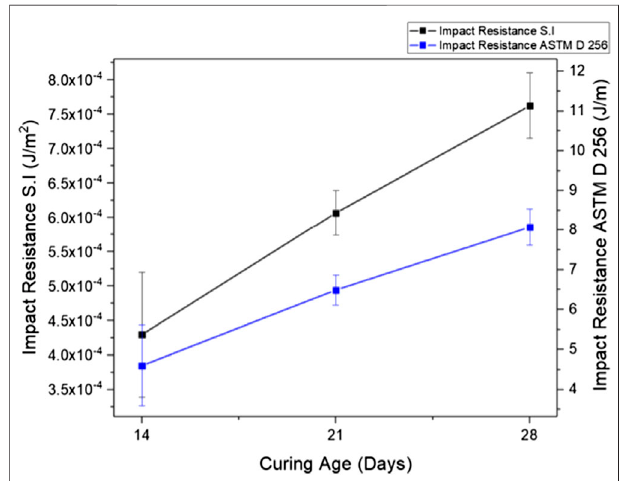
Frontiers in Materials |